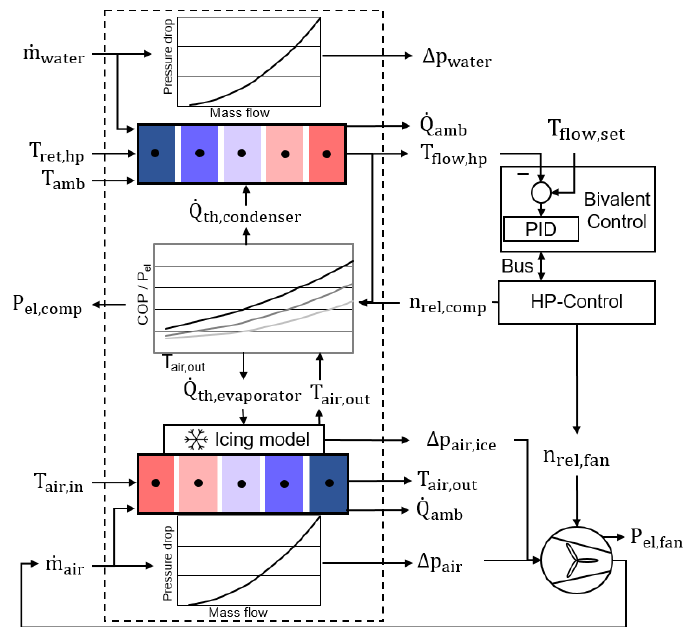
Figure 10. Thermohydraulic heat pump model with curve-based efficiency model and con- troller